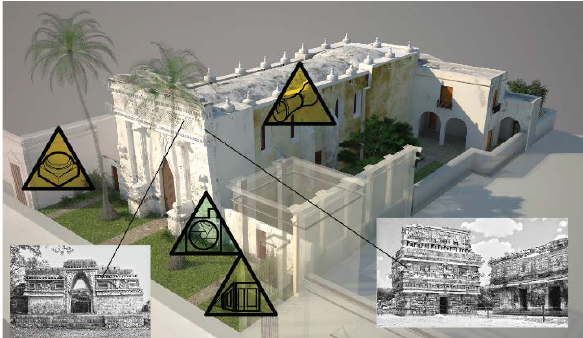
Figure 8. Virtual volumetric reconstruction of the Grand Lodge The Peninsular Oriental. Possible archaeological references that